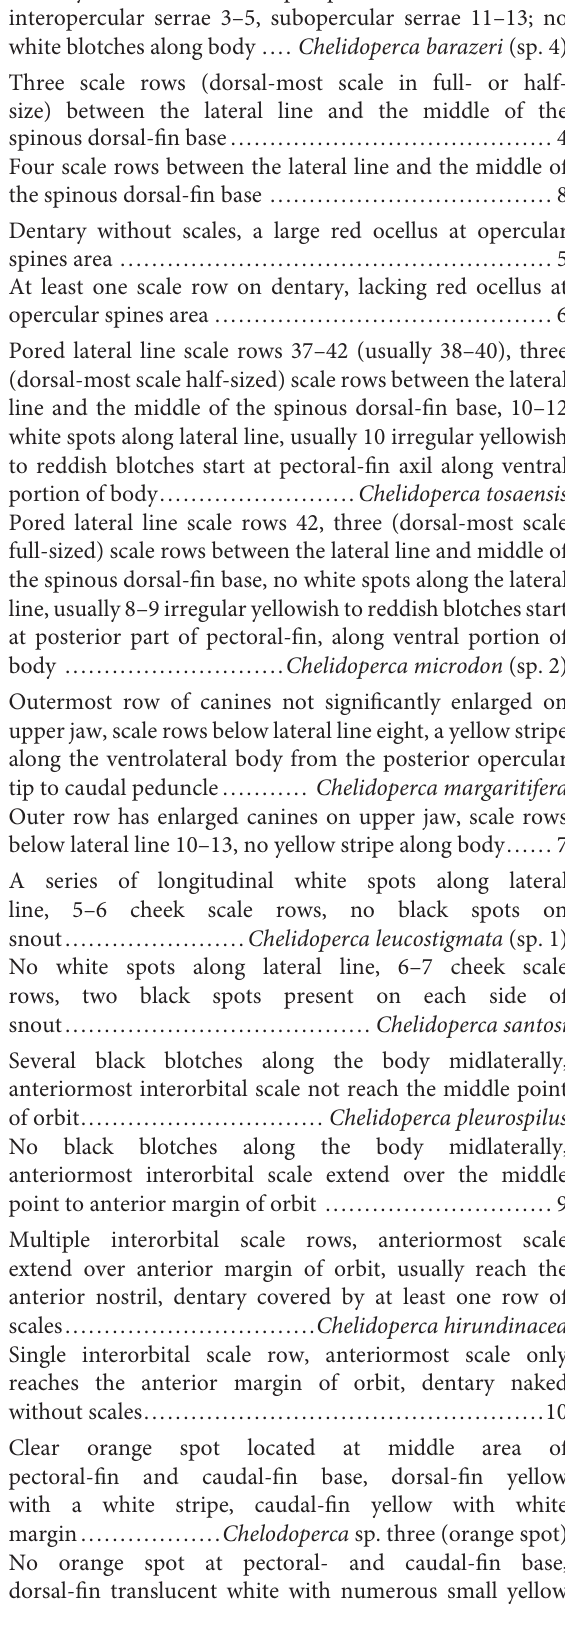
reaches the anterior margin of orbit, dentary naked 10a. Clear orange spot located at middle area of pectoral-fin and caudal-fin base, dorsal-fin yellow with a white stripe, caudal-fin yellow with white 10b. No orange spot at pectoral- and caudal-fin base, dorsal-fin translucent white with numerous small